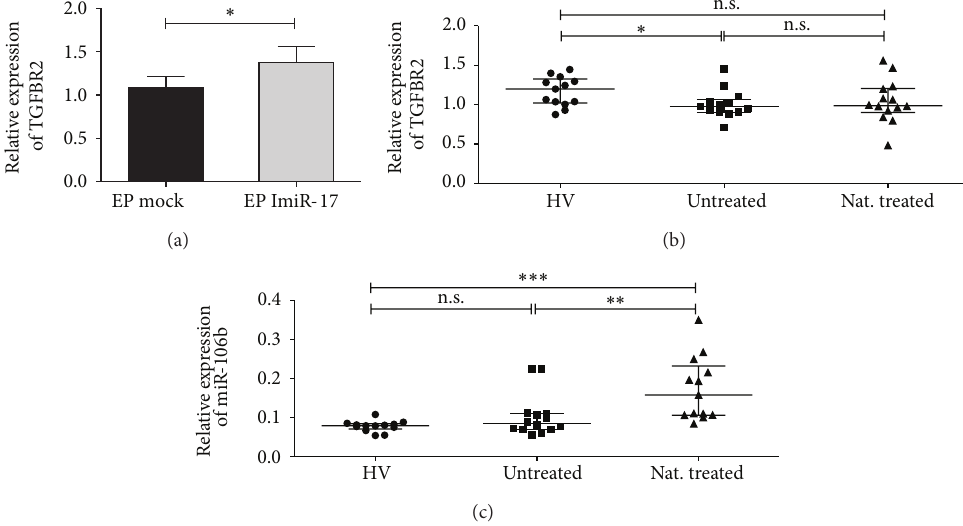
Figure 4: TGFBR2 and miR-106b expression analysis. (a) Transcriptional expression of TGFBR2 was analyzed with real-time RT-PCR in freshly isolated CD4 + T cells from HVs transiently transfected by electroporation (EP) with 1 𝜇 M of miR-17 synthetic inhibitor (ImiR-17) or vehicle control (mock) ( 𝑛 = 7 ) (bars represent mean with SEM) and (b) in CD4 + T cells from HVs and untreated and natalizumab treated patients ( 𝑛 = 14 ). (c) Analysis of transcriptional expression of miR-106b in CD4 + T cells from HVs and untreated and natalizumab treated patients ( 𝑛 = 14 ). Bars represent median with interquartile range. Relative expression levels are depicted. One-way ANOVA with Tukey’s multiple comparison test was applied. ∗∗∗ 𝑃 < 0.001 , ∗∗ 𝑃 < 0.01 ; ∗ 𝑃 < 0.05 ; n.s.: not